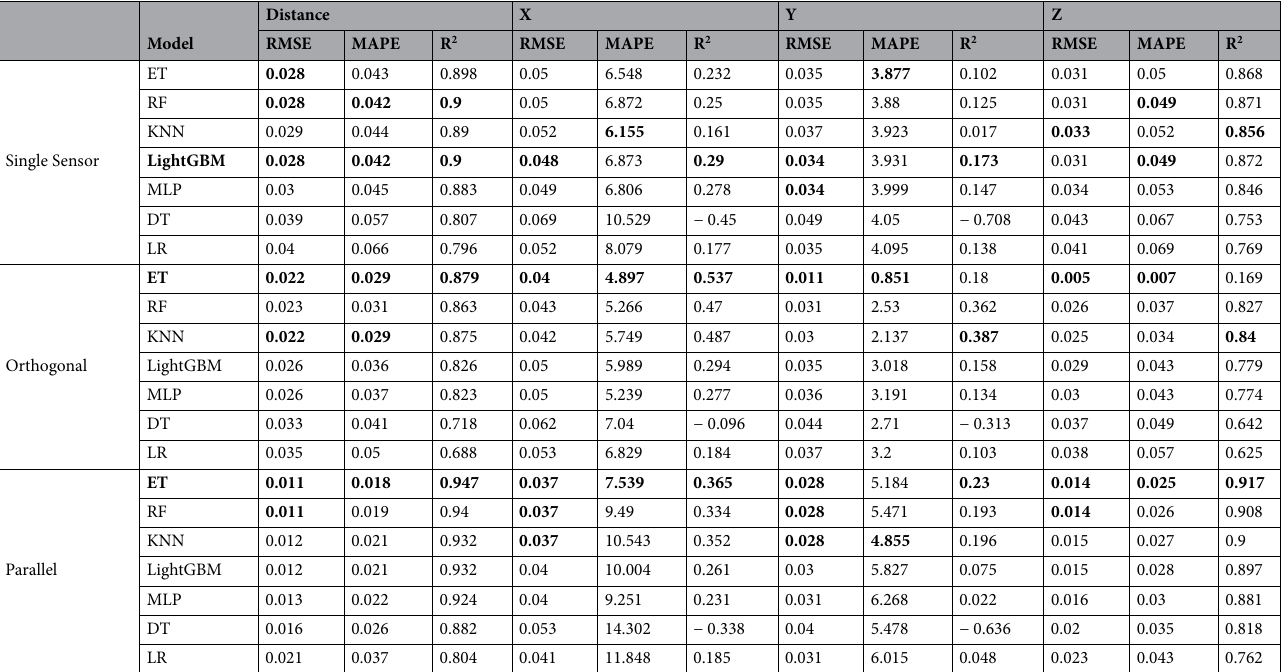
Table 1. Performance summary. Results of motion tracking algorithms on the synthetic data for different